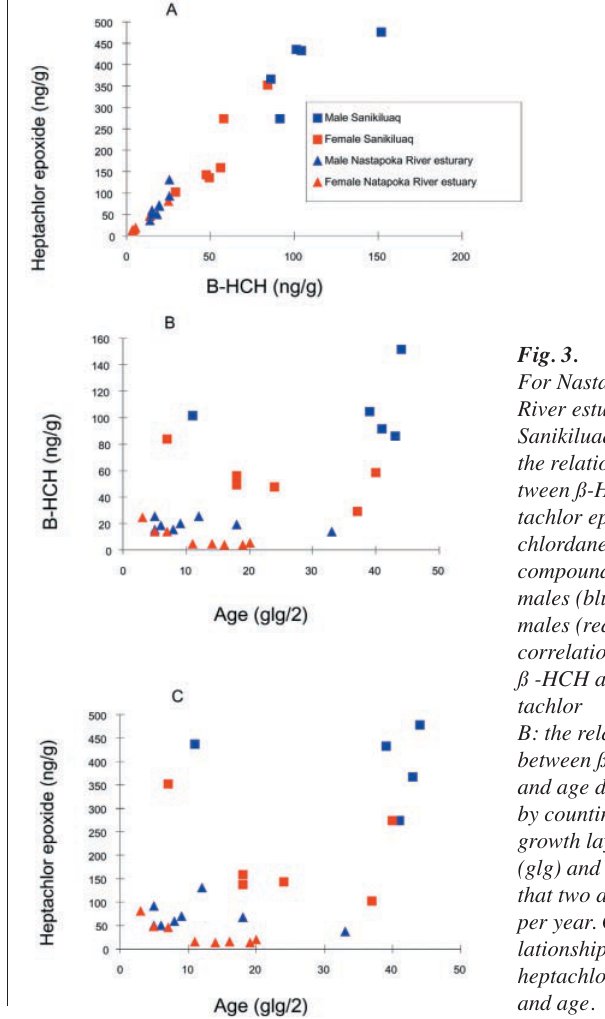
Fig. 3. For Nastapoka River estuary and Sanikiluaq belugas, the relationships be- tween ß-HCH, hep- tachlor epoxide (a chlordane-related compound), age and males (blue) and fe- males (red). A: the correlation between ß -HCH and hep- tachlor epoxide . B: the relationship between ß -HCH and age determined by counting the growth layer groups (glg) and assuming that two are formed per year. C: the re- lationship between heptachlor epoxide and